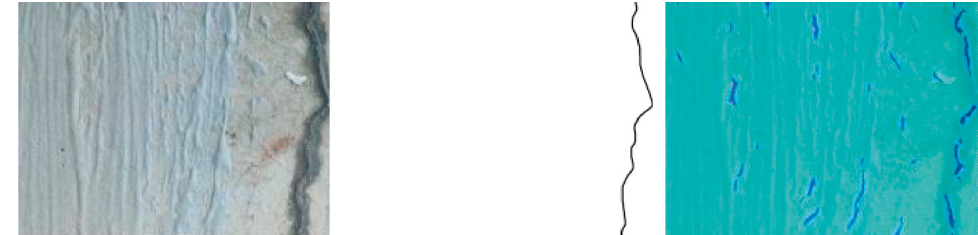
Figure 7: FCN-8s and new network concrete crease detection results.